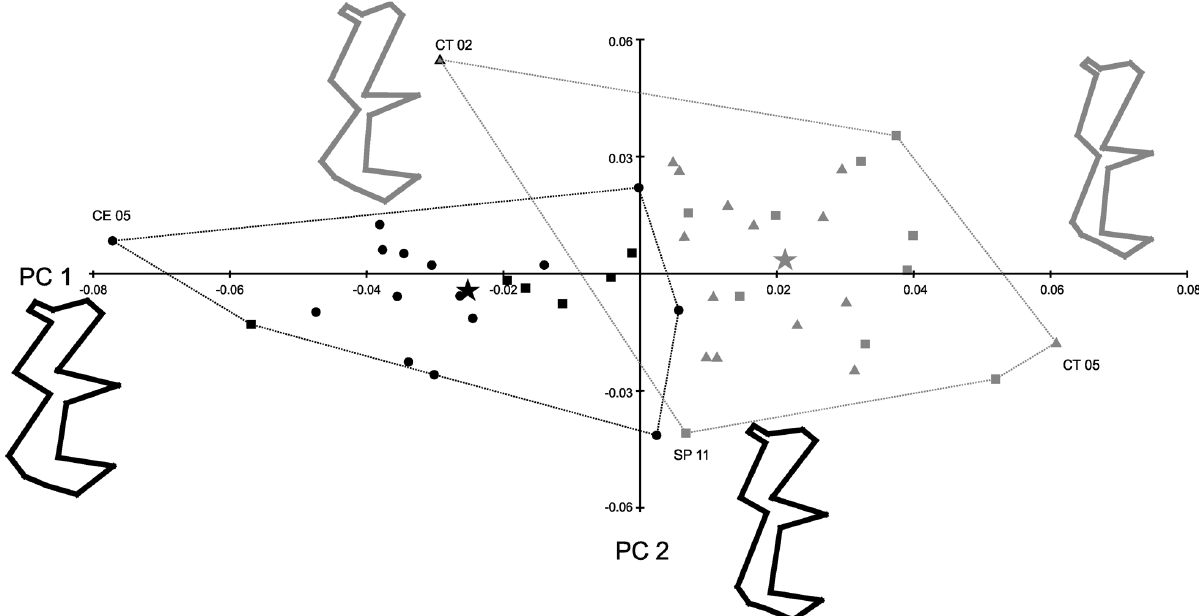
outlier).Figure 3. PCA showing the individual projections of Calomys sp., C. expulsus and C. tener in the two major axis (PC1 28.7%, PC2 12.3% of the variance). The wireframes illustrate shape differences between most different specimens: CE 09, CT 05, CT 02, and SP 11. Black circles: C. expulsus ; Gray triangle: C. tener ; Black square: Calomys sp. identified as C. expulsus ; Gray square: Calomys sp. identified as C. tener ; Gray triangle with black edge: specimen CT 02; Stars: mean shape for each species.